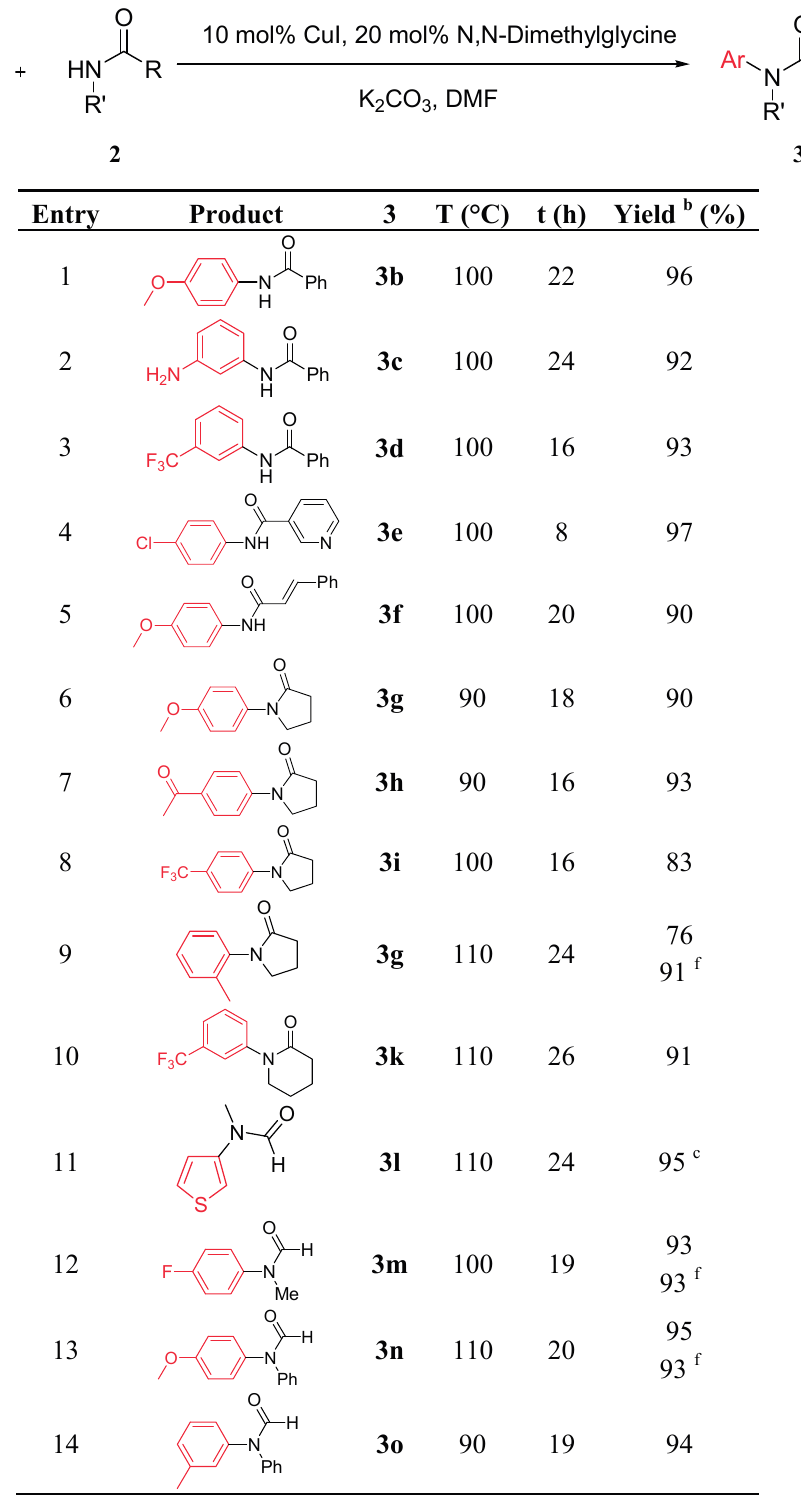
Table 2. CuI/ N,N -dimethylglycine catalyzed amidation of aryl bromides a